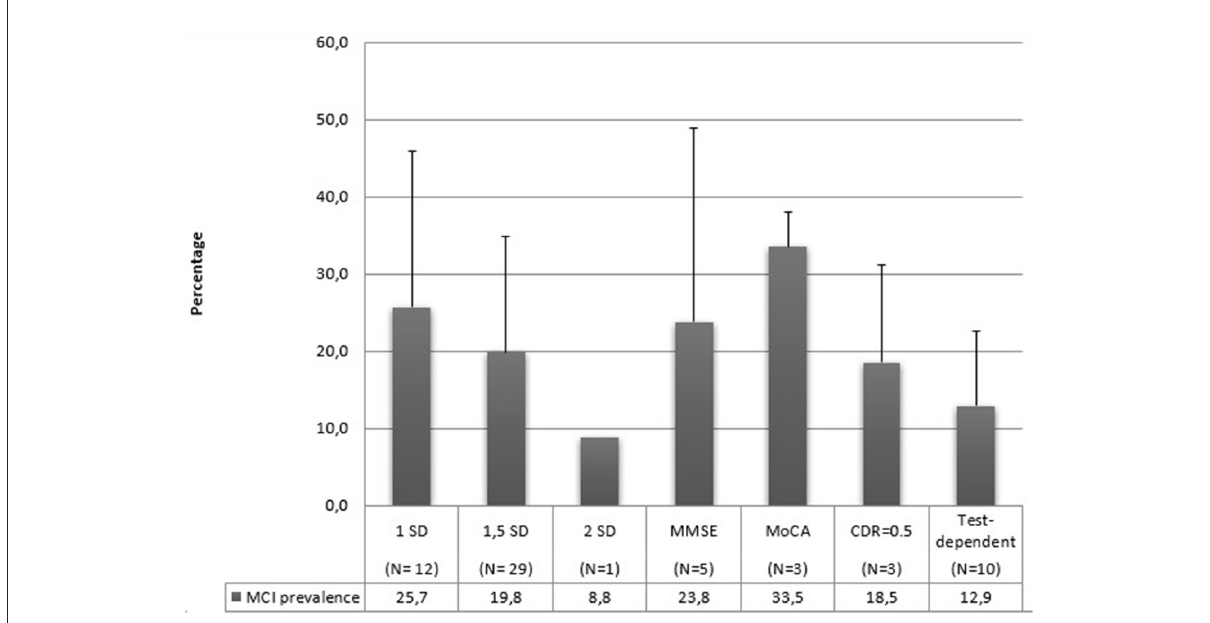
FIGURE7 MCI mean prevalence rates according to cut-off